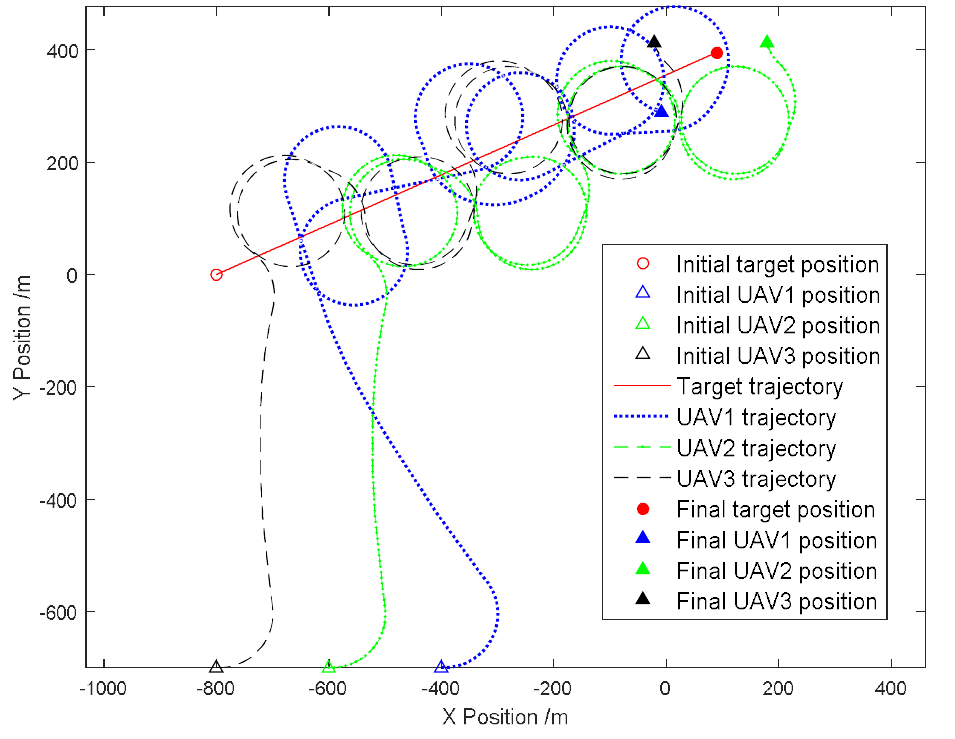
Figure 4. Target tracking trajectory with considering the communication noise between Unmanned Aerial Vehicles (UAVs).